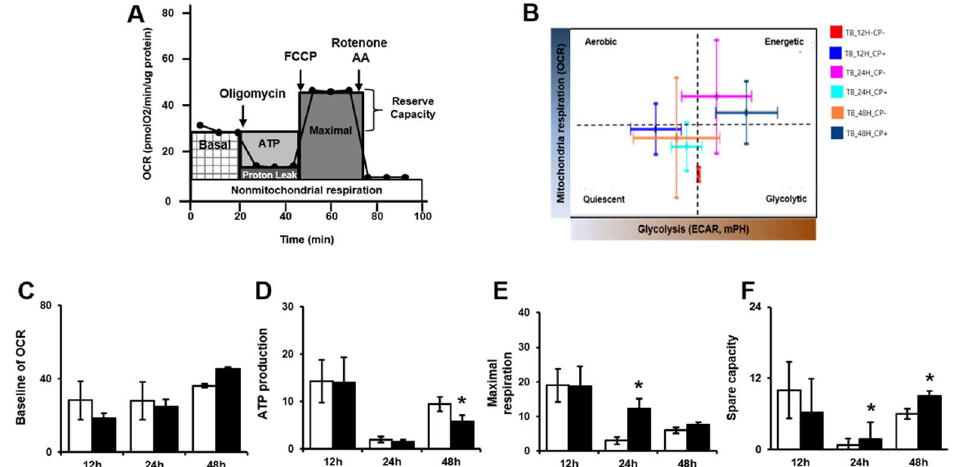
Figure 4. PD-MSCs regulate mitochondrial respiration in invasive trophoblasts. ( A ) Schematic illustration of the OCR. ( B ) The phenotypes of invasive trophoblasts with and without PD-MSC cocultivationovertime. ( C )ThebaselineOCR,( D )ATPproduction, ( E )maximalrespirationand( F )spare capacity of invasive trophoblasts with and without PD-MSC cocultivation were measured by XF assay. The data was performed in at least triplicate and expressed as the means ± S.D. Indicates * p < 0.05. White bar: control, Black bar: PD-MSC cocultivation. *: control vs. PD-MSC cocultivation at each